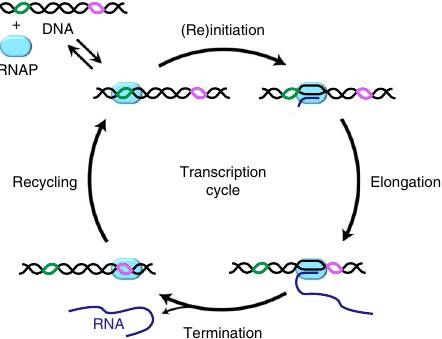
Fig. 7 Four stages of transcription cycle. (1) Initiation or reinitiation: after binding DNA (black line) at a promoter (green line), RNAP (cyan oval) incorporates several NTPs into RNA (blue line), and advances downward clearing the promoter. (2) Elongation: RNAP further advances processively downward, resuming from occasional pause or backtrack. (3) Termination: RNAP pauses at a terminator (magenta line) to undergo conformational changes, and releases RNA product. (4) Recycling: RNAP diffuses on DNA downward and upward until it reinitiates transcription at the same or another promoter unless RNAP dissociates off